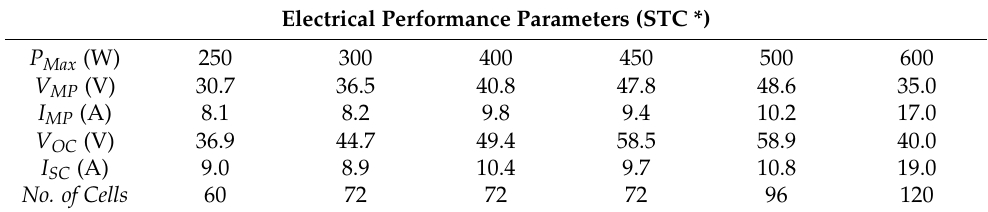
Table 1. Electrical Characteristics by Power Rating of PV Modules. Electrical Performance Parameters (STC *)